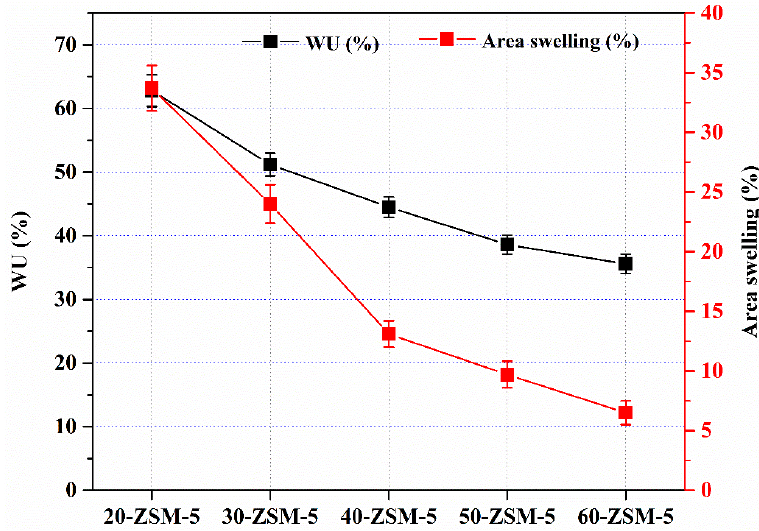
Figure 6. Water uptake (WU) and area swelling of the prepared MMMs.